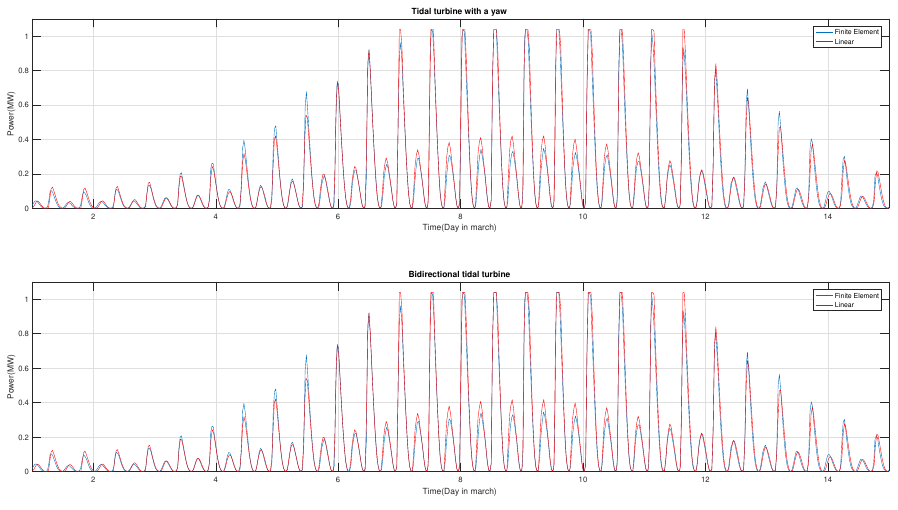
Figure 12. Time series of the predicted power production for yawed and fixed-axis turbines at point